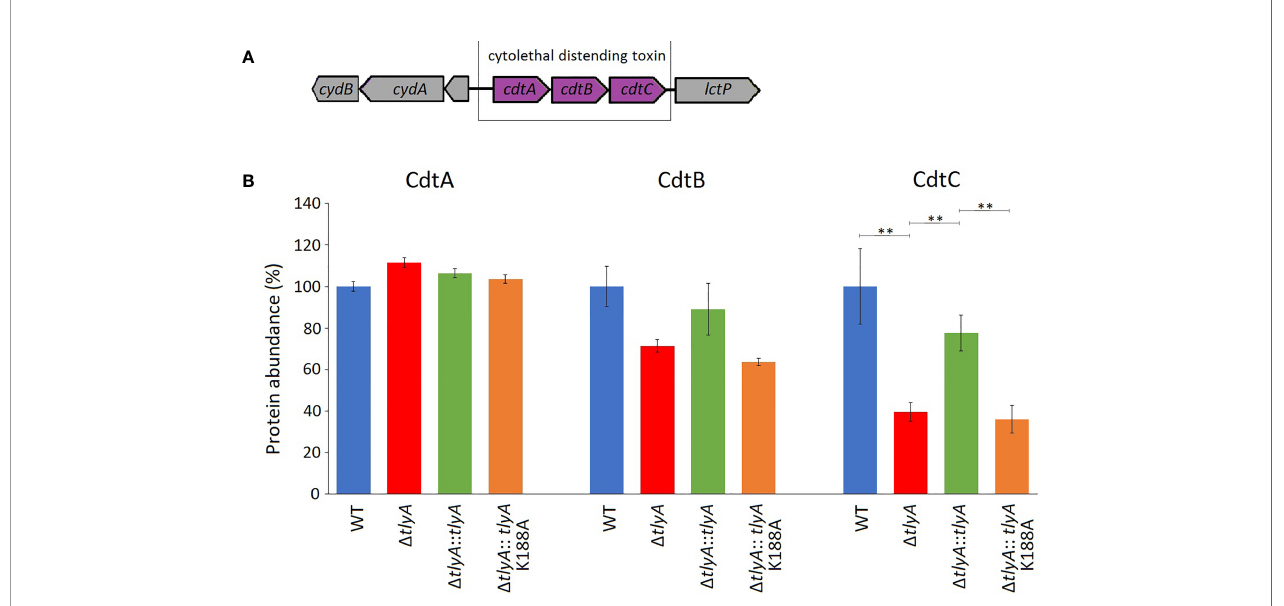
FIGURE 1 | Changes in the abundance of CdtABC proteins upon inactivation of the tlyA gene. (A) Organization of the cdtABC gene cluster in C. jejuni . The strain- speci fi c notations for these genes are given in . (B) Abundances of the individual Cdt proteins in the wild-type (WT) C. jejuni strain, the tlyA knockout strain ( D tlyA ), and the knockout strain complemented with active ( D tlyA::tlyA ) and inactive ( D tlyA::tlyA K188A ) copies of the tlyA gene. The protein amounts in the wild-type strain have been normalized here to 100%. The abundance of CdtC is dependent on a functional tlyA gene; CdtB is also reduced (but outside the signi fi cance cut-off applied here); and the upstream encoded protein CdtA remained unchanged. The error bars represent the standard deviations of three biological replicates; **P < 0.001 for these three strain comparisons.